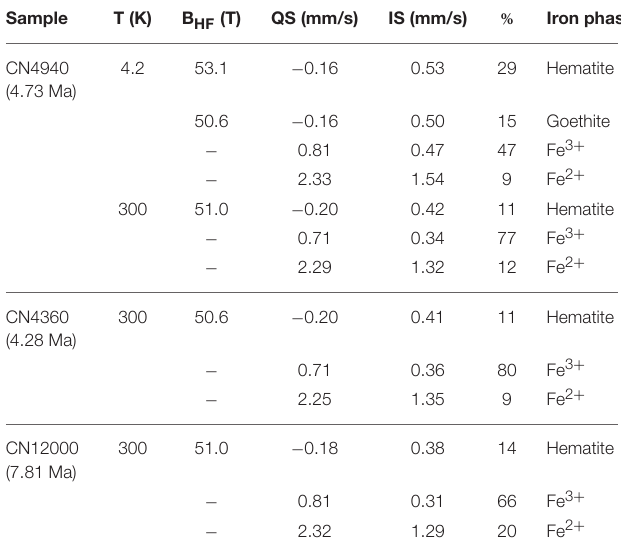
TABLE 1 | Magnetic hyperfine parameters of the red-clay sample CN 4940, CN4360, and CN12000.